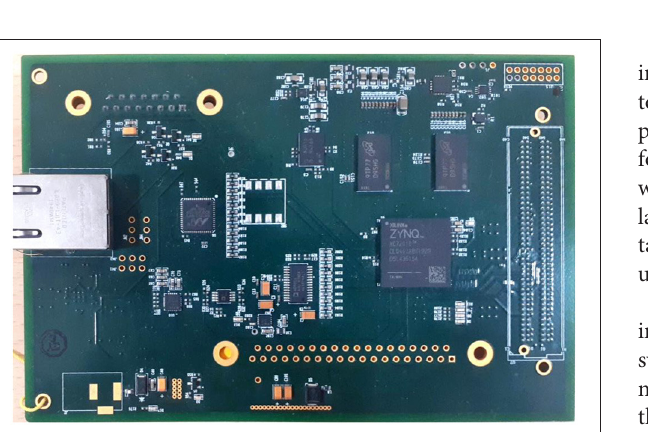
FIGURE 6 | Flow diagram for extraction of cardiac sound components.